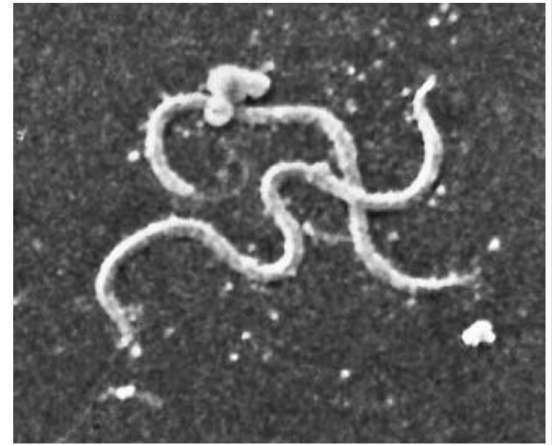
Figure 4. Scanning electron microscopy (SEM) image of Borrelia burgdorferi in BSK culture medium from the spirochaete laboratory, Trieste, Italy (photo by M.